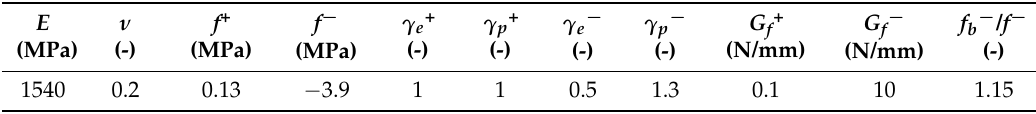
Table 4. Constitutive properties adopted in the numerical